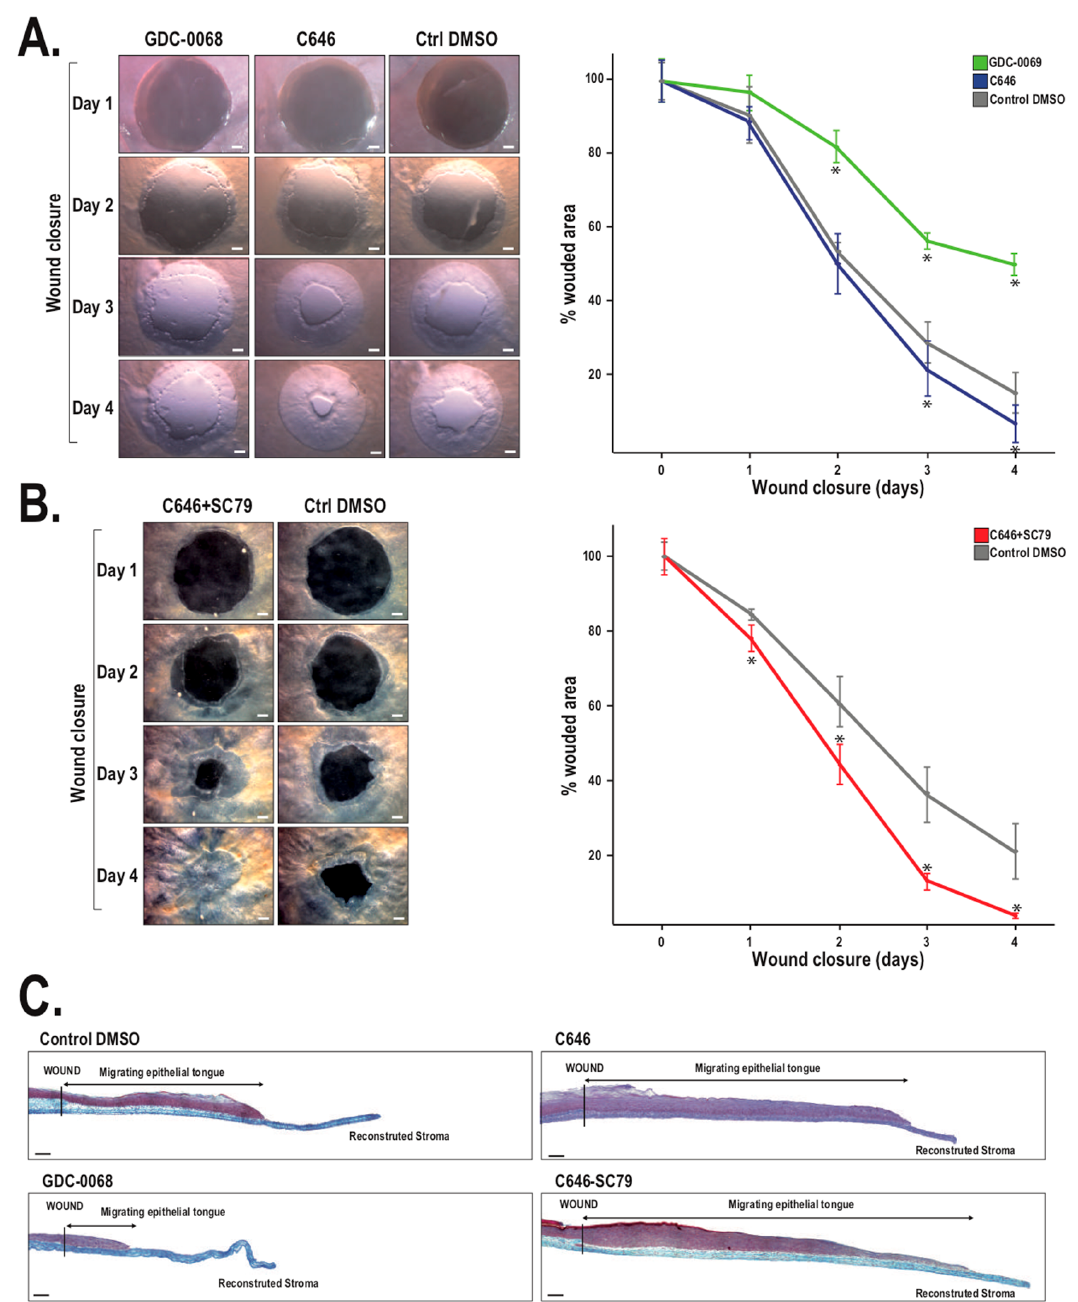
Figure 6. Impact of GDC-0068, C646, and SC79 on wound closure of human TECs. ( A ) Human TECs (one out of four representative hTECs is shown for each condition) were wounded and maintained in culture medium supplemented with GDC-0068 or C646 ( left ). Wound surfaces remaining for each condition were determined at each day and plotted on the graph ( right ). Control wounded hTECs were exposed solely to the vehicle (DMSO). Scale bars: 1 mm. ( B ) Wounded hTECs were incubated with both C646 and SC79 ( left ); one out of six representative hTECs is shown for each condition). Wound surfaces remaining were determined at each day and plotted on the graph ( right ). Control wounded hTECs were exposed solely to the vehicle (DMSO). Scale bars: 1 mm. ( C ) Composite images showing a complete histological view of wounded TECs grown in the presence of GDC0068, C646, or both the combination of C646 and SC79 at 4 days following corneal damage (sections were stained with Masson trichrome; cells are pink, and collagen is bluish). The wound margin created by the biopsy punch is indicated. Scale bar: 100 µm (Figure adapted from Reference [171] with the permission of the journal ACTA Biomaterialia).